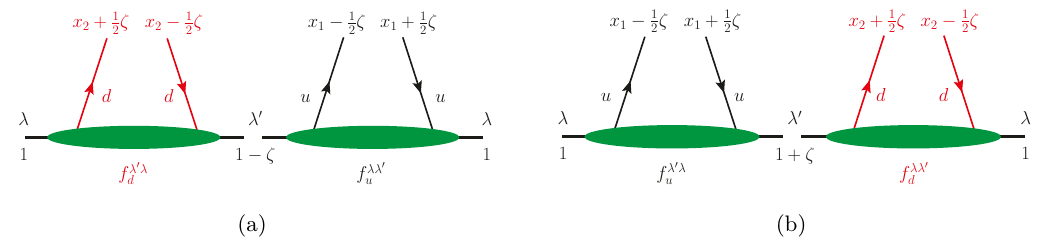
Figure 23 . Illustration of the approximation of a DPD in terms of GPD matrix elements f λλ 0 for the flavor combination ud . Panel (a) shows the factorization ansatz to be used for the case ζ > 0 , whereas (b) depicts the variant that we employ if ζ < 0